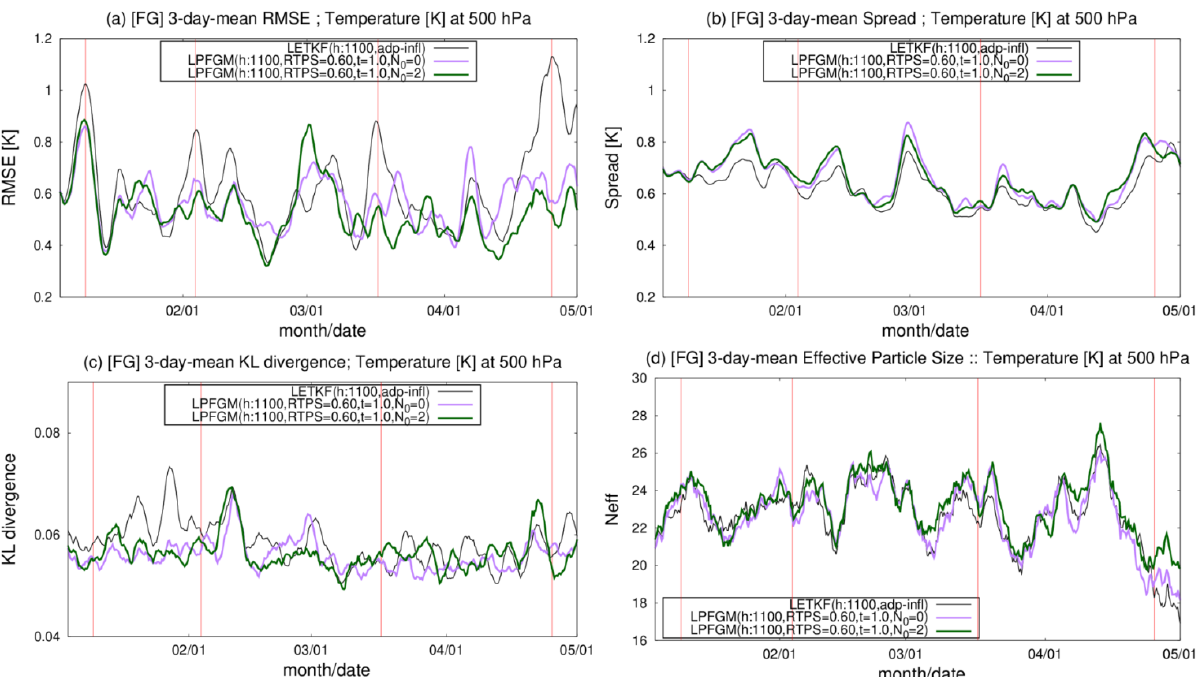
Figure 14. Time series of 3d-mean (a) RMSE (K), (b) ensemble spread (K), (c) Kullback–Leibler divergence, and (d) effective particle size N eff at fourth model level temperature T , averaged over the region indicated by rectangles in Figs. 12 and 13 (120–60 ◦ W and 70–30 ◦ S). The black line represents the LETKF. Green and purple lines are the LPFGM whose resampling frequencies N 0 are 2 and 0, respectively. Vertical red lines represent the cases when the LETKF shows large RMSE greater than 0.8K. In (d) , the effective particle size is also computed for the LETKF using the first-guess